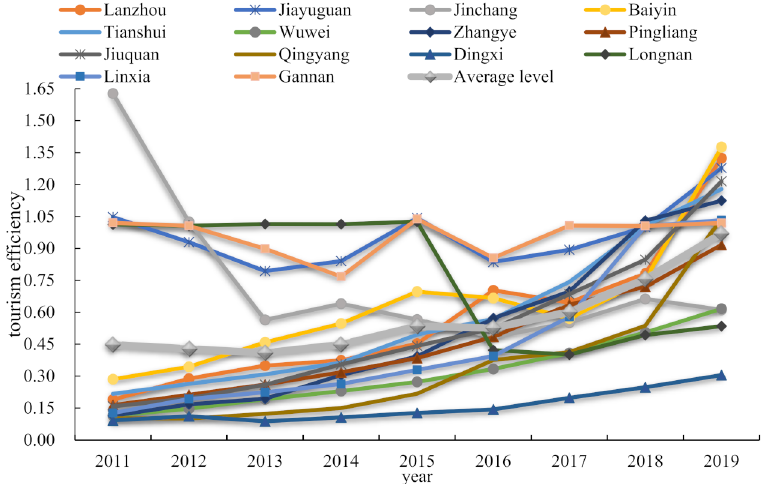
Figure 2. The changing trend of tourism efficiency in Gansu Province during